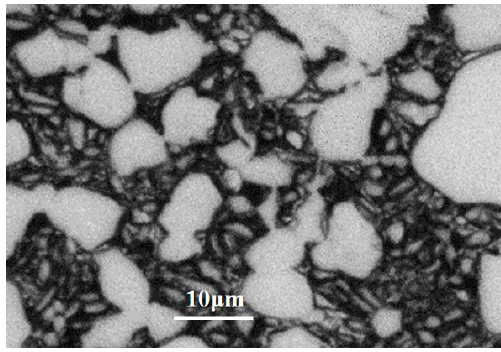
Figure 1. Initial microstructure of the as-received wrought TA15 alloy.